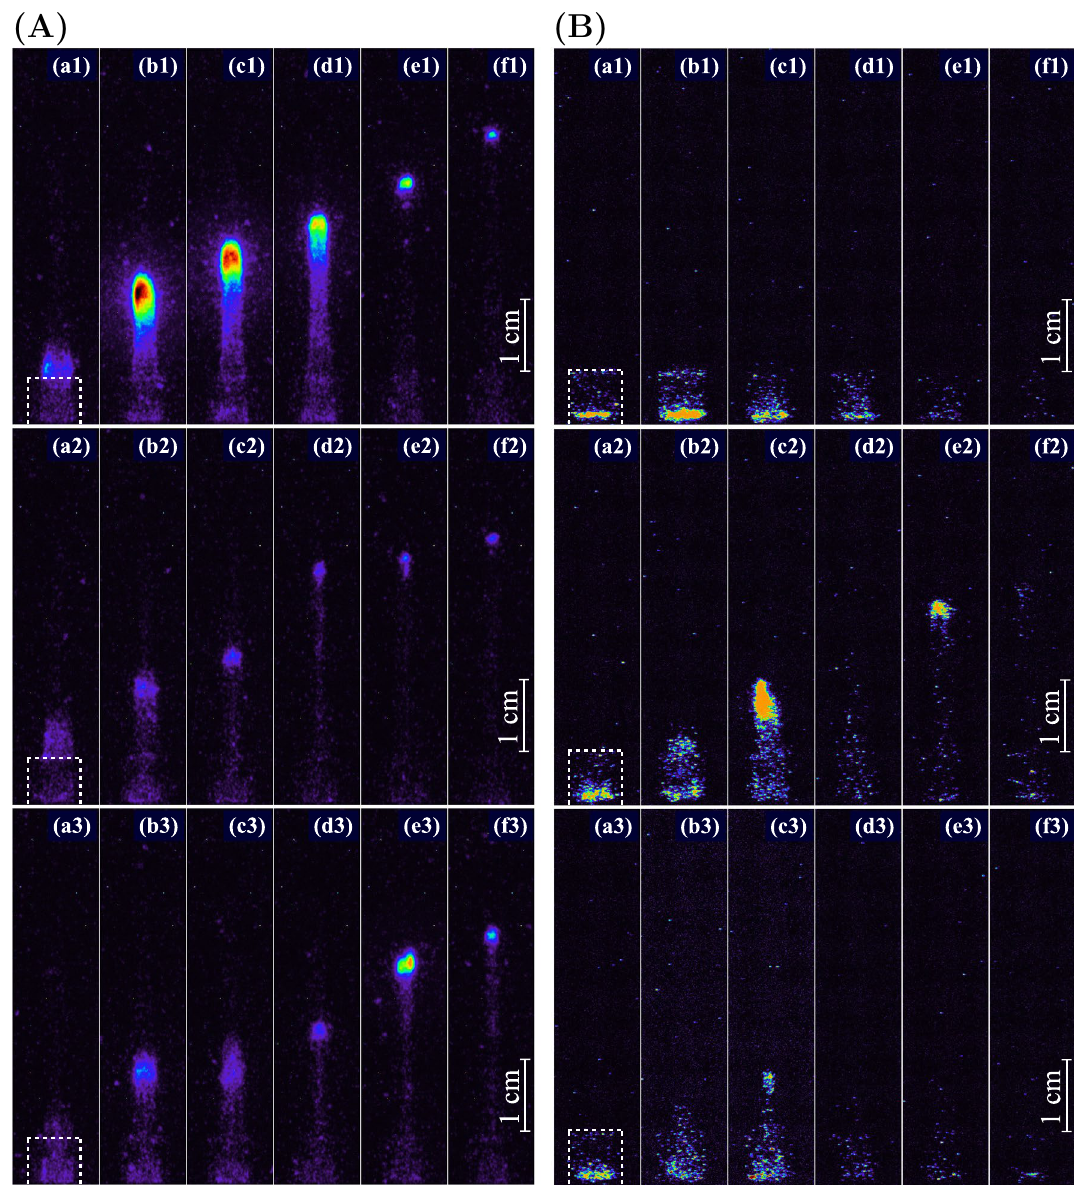
Figure 2. ( A ) ICCD images at the first three positive pulses for the first negative pulse in the bunch with duty cycle of ≈ 8 %: ( a1 ) at 12.8, ( b1 ) 13.1, ( c1 ) 13.3, ( d1 ) 13.5, ( e1 ) 15.5 and ( f1 ) 16.1 µ s; ( a2 ) at 38.8, ( b2 ) 39.1, ( c2 ) 39.3, ( d2 ) 39.5, ( e2 ) 41.5 and ( f2 ) 42.1 µ s; ( a3 ) at 64.8, ( b3 ) 65.1, ( c3 ) 65.3, ( d3 ) 65.5, ( e3 ) 67.5 and ( f3 ) 68.1 µ s. ICCD exposure time is of 50 ns with 50 accumulations. The dashed contours are the tube’s borders. The time of the images correspond to Fig. 3A. ( B ) ICCD images at the first positive pulse in the bunch: ( a1 ) at 3.0, ( b1 ) 3.6, ( c1 ) 4.0, ( d1 ) 5.4, ( e1 ) 6.8 and ( f1 ) 10.2 µ s; ( a2 ) at 24.0, ( b2 ) 24.6, ( c2 ) 25.0, ( d2 ) 26.4, ( e2 ) 27.8 and ( f2 ) 28.5 µ s; ( a3 ) at 44.6, ( b3 ) 45.2, ( c3 ) 45.6, ( d3 ) 47.0, ( e3 ) 48.4 and ( f3 ) 52.0 µ s. ICCD exposure time is of 50 ns with 5 accumulations. The dashed contours are the tube’s borders. The time of the images correspond to Fig. For example, the positive charge through the circuit at a positive voltage half-cycle is greater by ≈ 0.05 –0.1 nC than the negative charge at the negative voltage half-cycle from the statistical analysis 42 for a surface dielectric- barrier discharge in air at a steady state regime, when a flowing charge in the circuit was estimated to be ≈ 0.1 –0.4 nC per voltage period. Because of the difference in charge generated in positive and negative half-period of the applied voltage, the charge starts to propagate from the discharge area into the surrounding space, forming a positive charge cloud around the discharge system 42 . The difference between the transfered positive and nega- tive charges in the recent work 43 was of the same order value for the helium plasma jet, which is similar to our configuration. The positive space charge formed in plasma jet 44,45 is characterized by a volume charge of ∼ 1 nC as found in simulations of the guided streamer development in the helium jet. A charge of ≈ + 0.1 nC in a ∼ 0.5 cm diameter cloud has a potential of ∼ 1 kV in the cloud center 46 and the 3 9 charge corresponds to a concentration of ∼ 10 cm − . This potential can stop the streamer development 24 . On